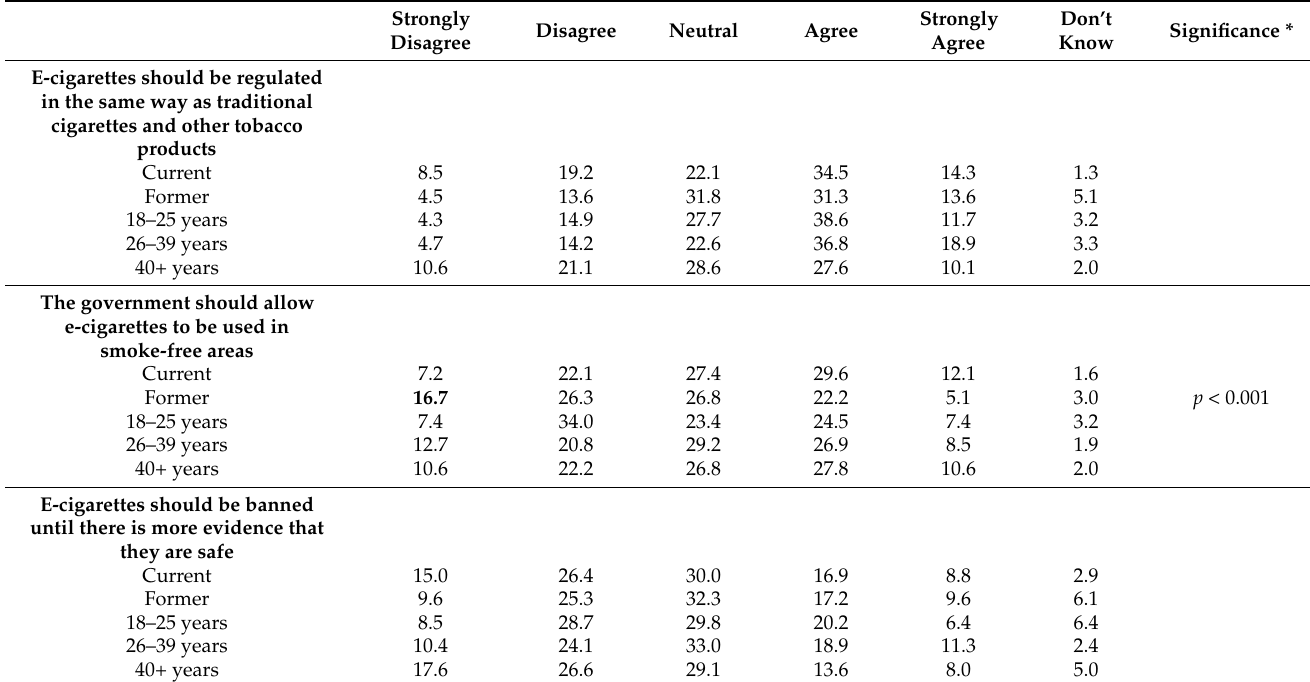
Table 4. Perceptions around e-cigarette regulations stratified by current and former e-cigarette users and by age. Data presented are percentages. Numbers in bold indicate significantly greater than expected compared within current/former e-cigarette user, or within a particular age